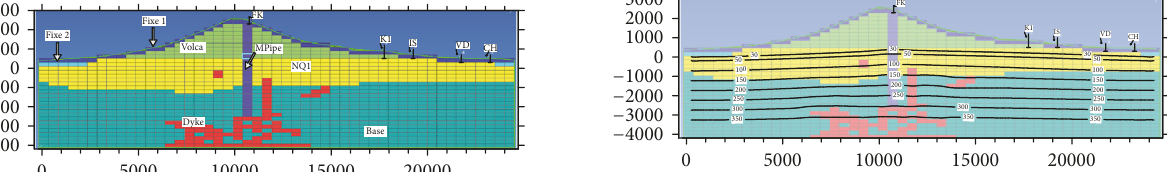
Figure 12: Revised model grid, zonation, and boundary conditions (compare to Figure 6) (6A + I). Domain MPipe (Koryaksky Volcano funnel) has been added, and the blue rectangle inside this domain corresponds to the water level in the volcano funnel. Horizontal and vertical axes are labeled in meters.